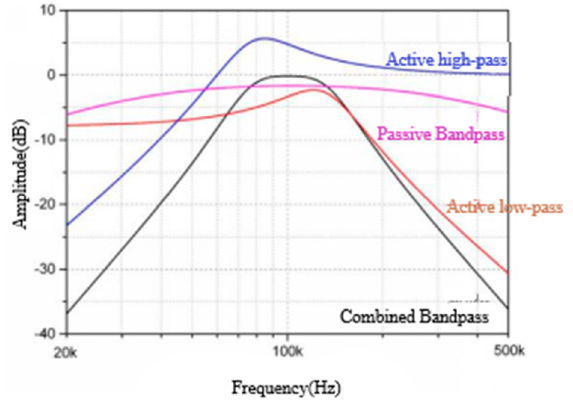
Figure 7. Planar transformer developed in this paper.